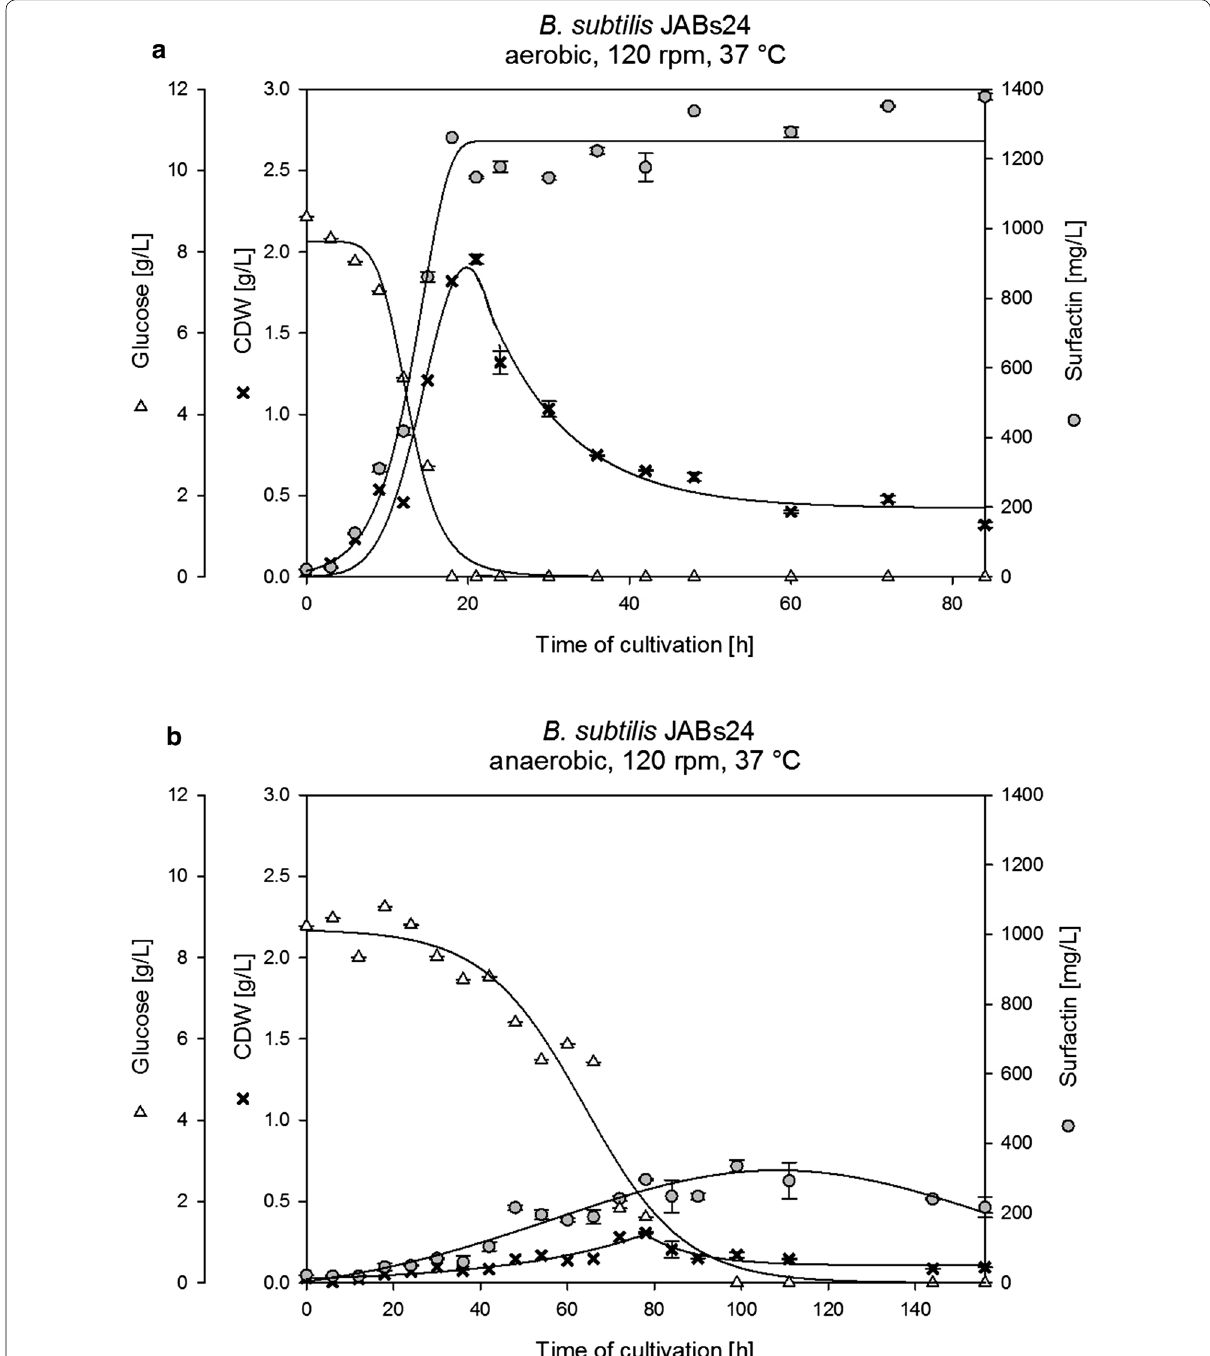
Fig. 1 Exemplary time course of CDW (black cross) and surfactin (grey circle) in comparison to glucose (open triangle) during the cultivation of B. subtilis JABs24 under a aerobic and b anaerobic conditions at 37